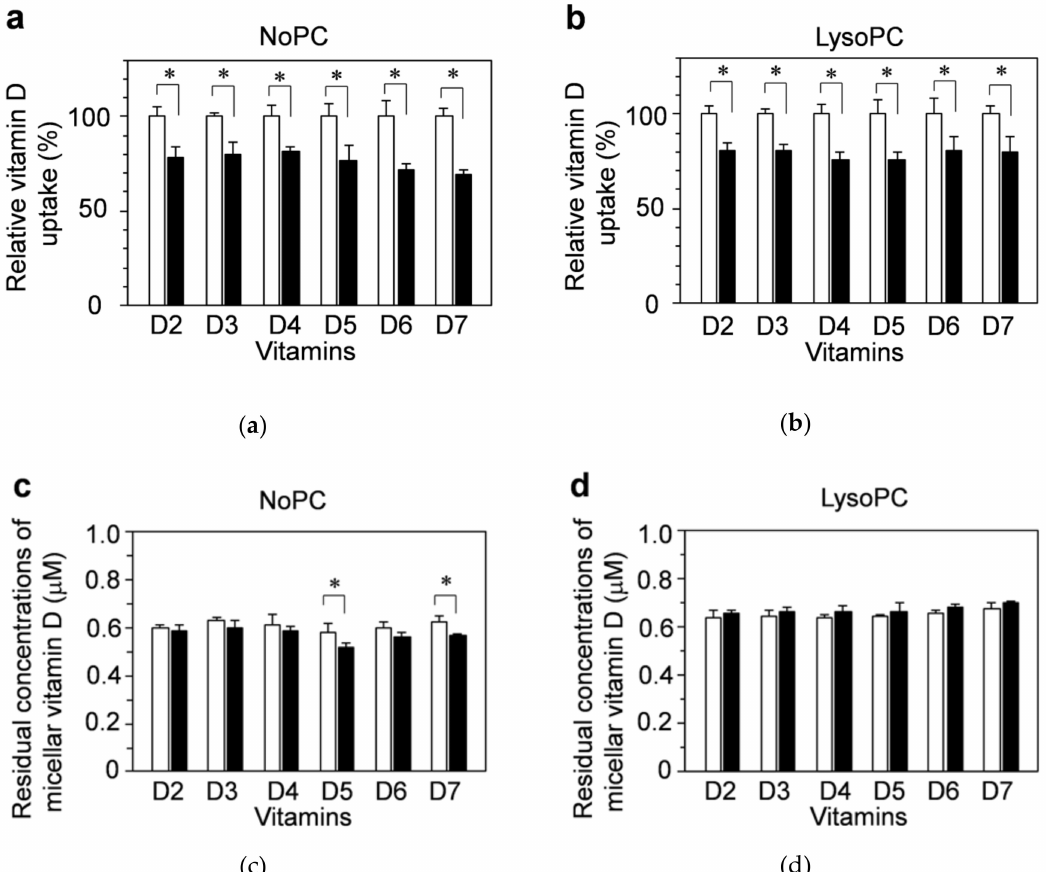
Figure 3. Inhibitory effects of ezetimibe on the uptake of vitamin D solubilized in mixed micelles by differentiated Caco-2 cells. Differentiated Caco-2 cells were pretreated for 2 h with the vehicle (1.5% dimethyl sulfoxide (DMSO), open bars) alone or with 150 µ M ezetimibe (filled bars), which is an inhibitor of the protein Niemann-Pick C1-like 1 (NPC1L1), and then incubated for 2 h with vitamin D in NoPC mixed micelles (left side) and lysoPC mixed micelles (right side). ( a , b ): Vitamin D uptake by differentiated Caco-2 cells. ( c , d ): Residual concentrations of micellar vitamin D after 2-h incubation with the cells. Data are presented as the means ± standard deviation of four wells in a single experiment. Replicate experiments showed a similar trend. Statistical analysis was performed to compare each vitamin D with and without ezetimibe. The asterisk indicates a value with significant difference as determined by unpaired t -test ( p <